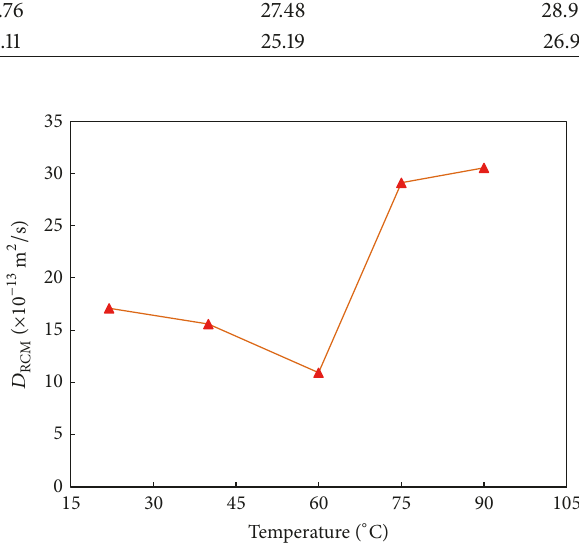
Figure 5: Effect of temperature on chloride ion